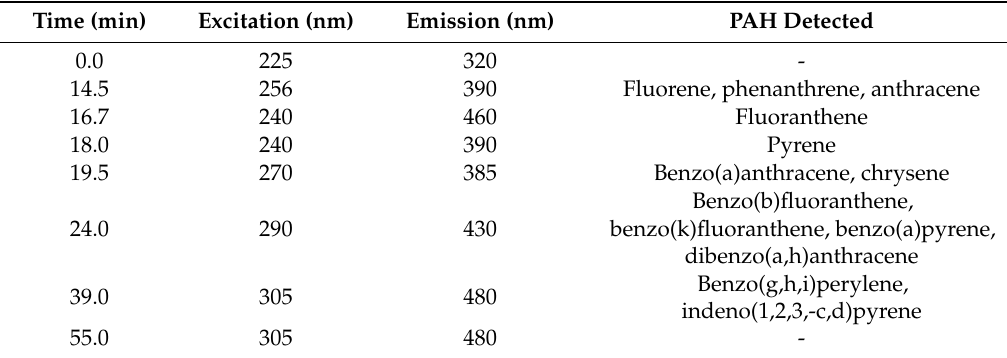
Table 2. Fluorescence detector program for detection of individual PAH